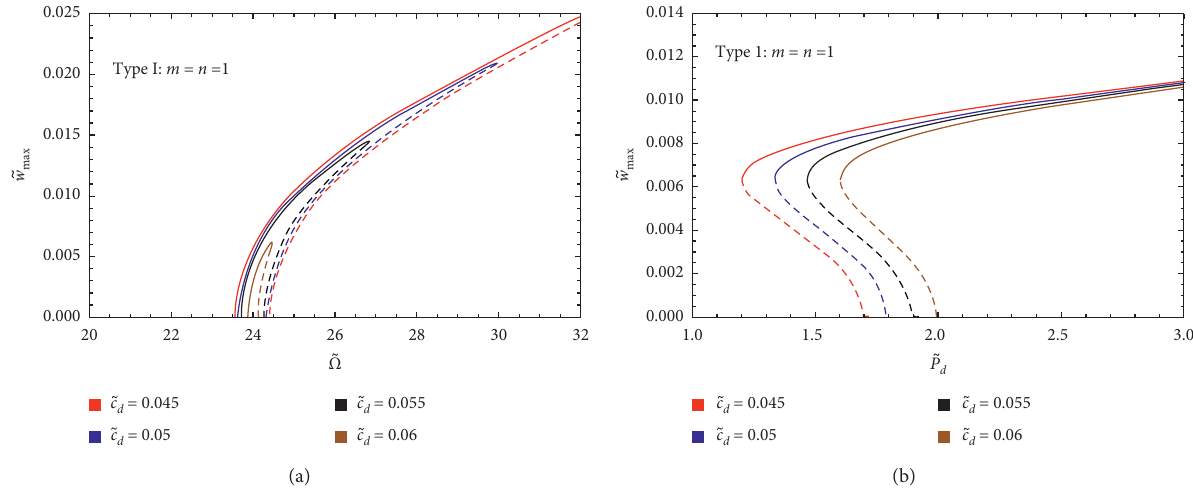
Figure 13: The effects of damping coefficients c (a) Frequency-response curve, P d � 1 . 6. (b) Force-response curves, 􏽥 Ω � 1 . 02 × 2 􏽥 ω l